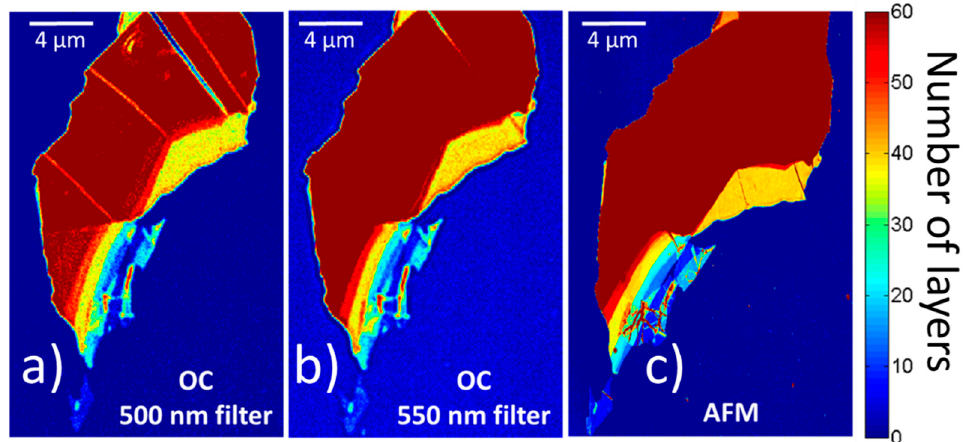
Figure 3. Comparison of optical contrast (OC) images recalculated as function of number of hBN layers obtained by fitting of experimental data for ( a ) 500 nm, ( b ) 550 nm bandpass filter illumination with ( c ) AFM image.